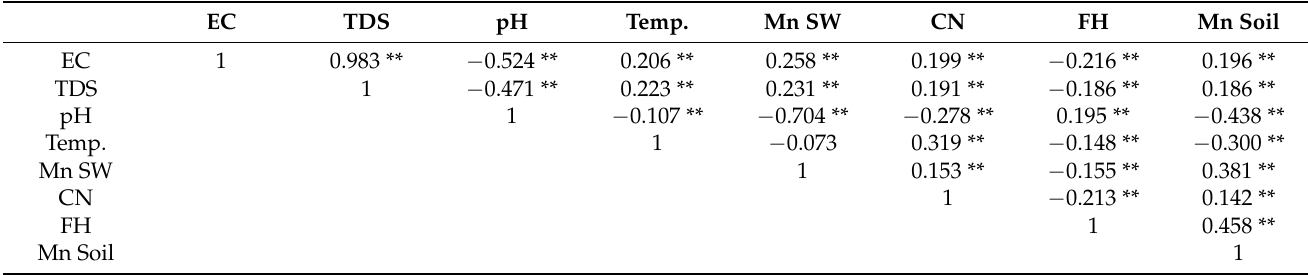
Table 2. Correlation analysis of EC, TDS, pH, and Temp. of SW, Mn in SW, CN, flood height with Mn content of soils.